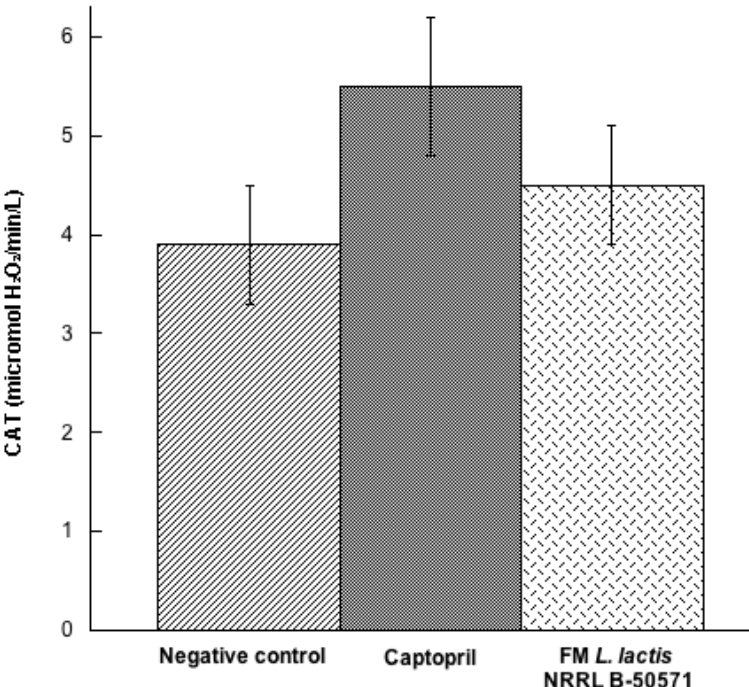
Figure 8. Catalase activity (CAT) (micromol H 2 O 2 /min/L) in plasma from spontaneously hypertensive rats after long-term treatments. Negative control: purified water; Captopril: 40 mg/kg body weight; FM L. lactis NRRL B-50571 (ad libitum): fermented milk with L. lactis NRRL B-50571. Data are presented as means ± SEM, and were analyzed by one-way ANOVA.